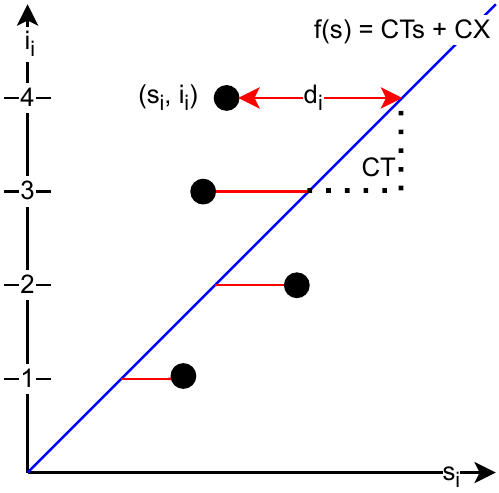
Figure 3. Distance of cognitive